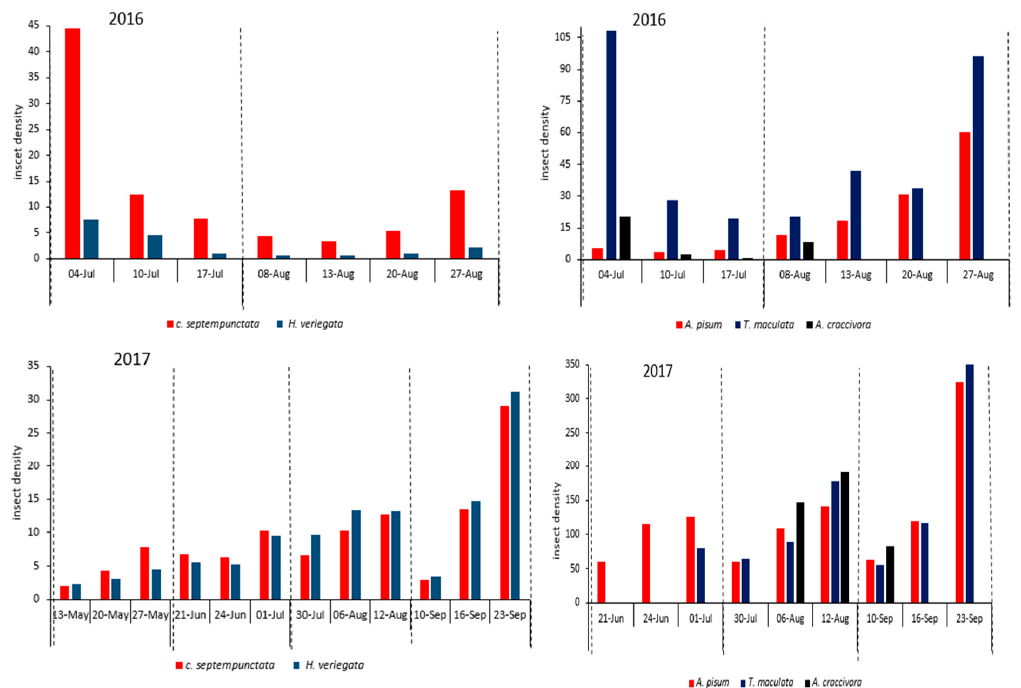
Figure 1. Temporal dynamics of the coccinellids (left) and aphids (right) in the studied alfalfa fields in the first, second, third, and fourth weeks after harvest (dashed lines indicate alfalfa harvest times). Coccinellids were sampled using a 1 × 1 m quadrat and aphids counted on 20 stems were cut randomly from each grid.